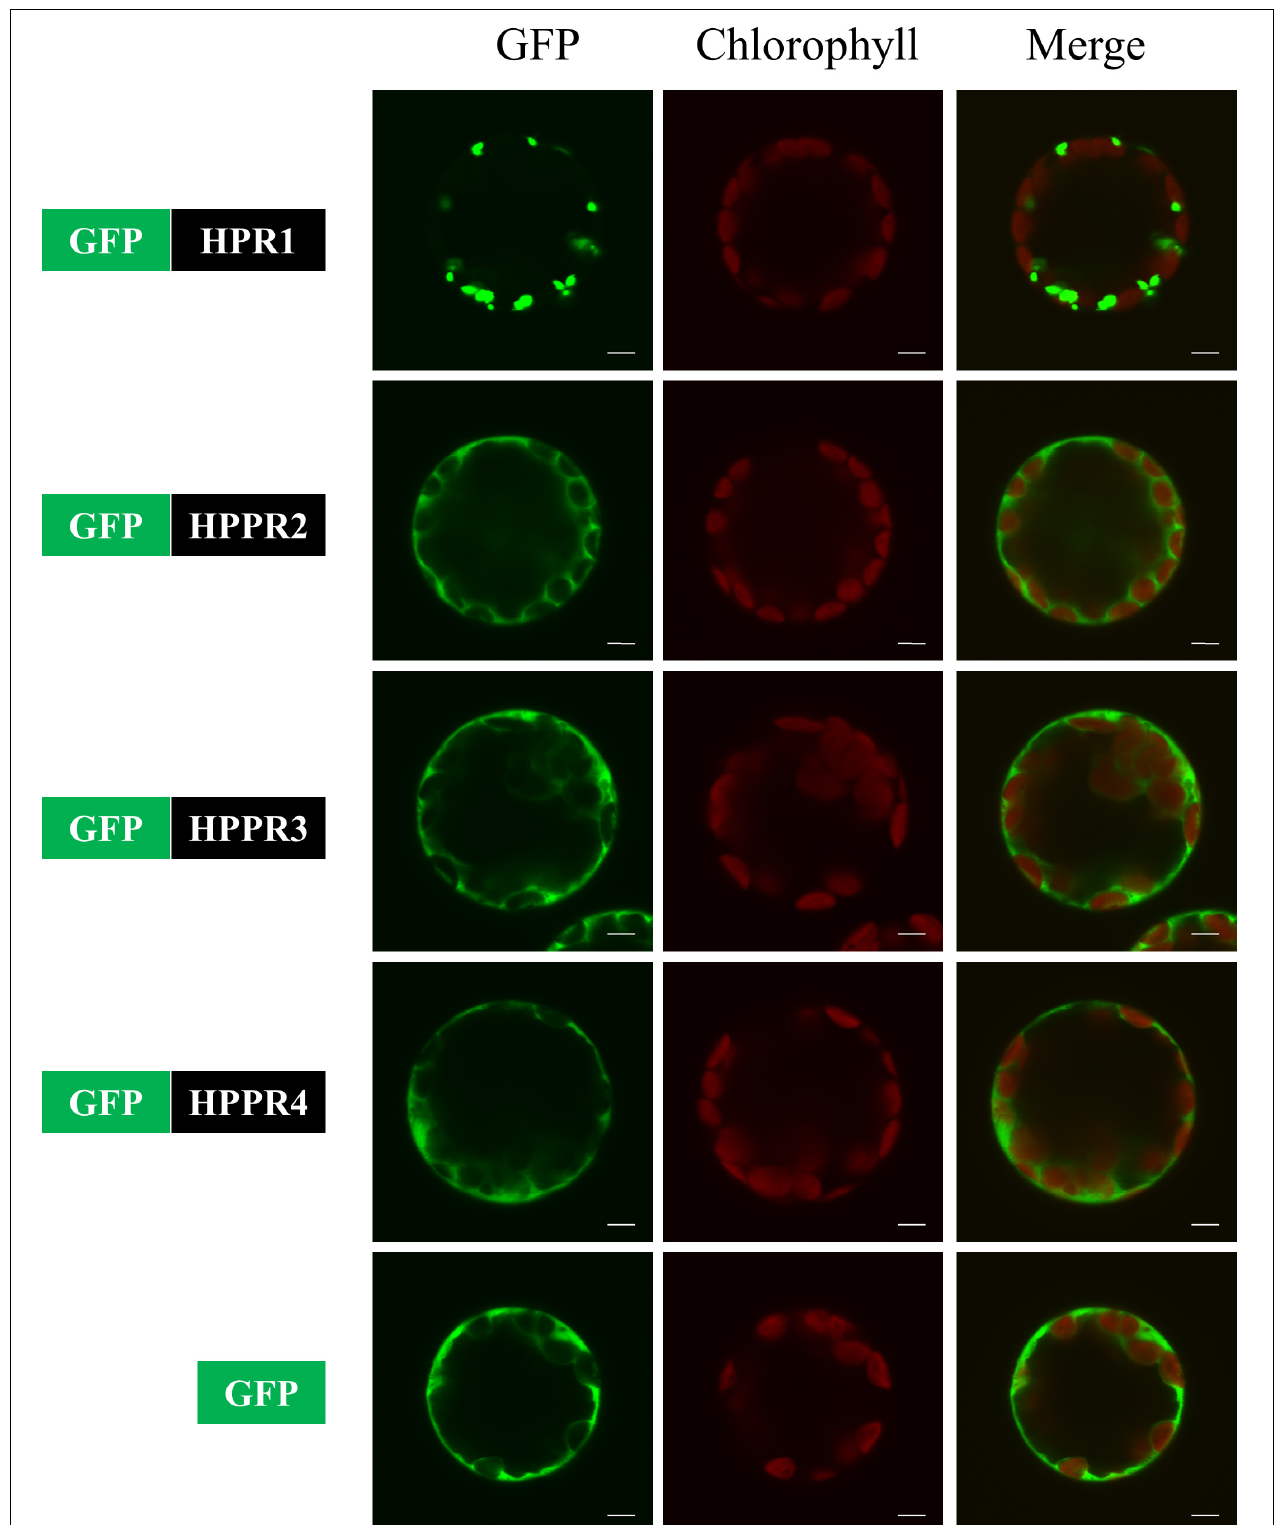
FIGURE 4 | HPPR2, HPPR3, and HPPR4 are localized in the cytosol. The GFP was fused with HPR1, HPPR2, HPPR3, or HPPR4 and transiently expressed in Arabidopsis protoplasts. Free GFP was used as a control. GFP fluorescence, chloroplast autofluorescence, and the merged images are shown. Bars = 5 µ m.